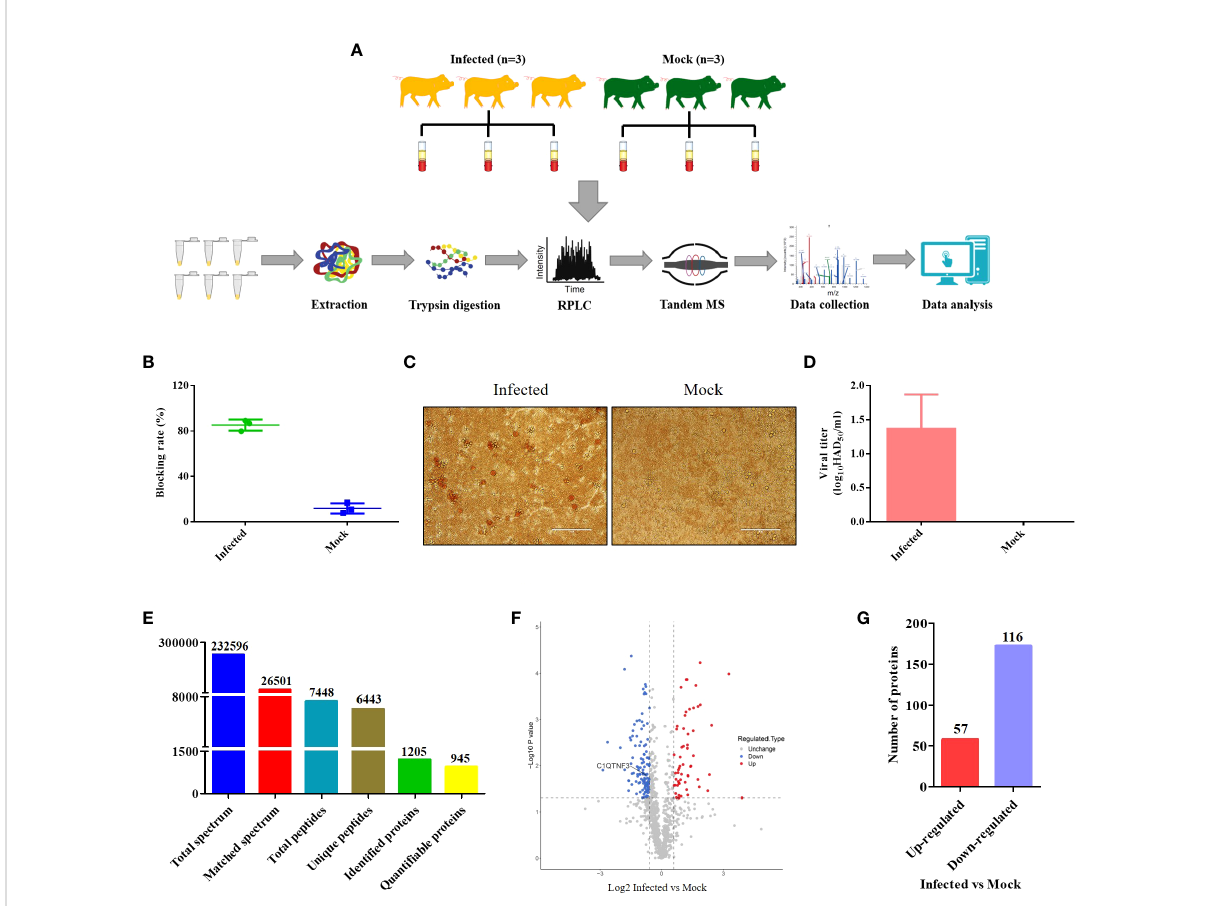
FIGURE 1 Schematic of the experimental method and data on the differentially expressed proteins (DEPs) identi fi ed between the ASFV-infected and uninfected serum samples using proteomics. (A) The serum samples of three ASFV-infected and uninfected pigs were collected from the same pig farm and subjected to quantitative proteomics through tandem mass spectrometry technology, high-performance liquid chromatography, and mass spectrometry. (B) Antibody, (C, D) Titer of the African swine fever virus was measured between the ASFV-infected and uninfected serum samples using ELISA and the HAD assay, respectively. (E) Summary of the quantitative proteomics data of swine serum samples. (F) Volcano map of DEPs between the ASFV-infected and uninfected serum samples. (G) Number of DEPs between the ASFV-infected and uninfected serum